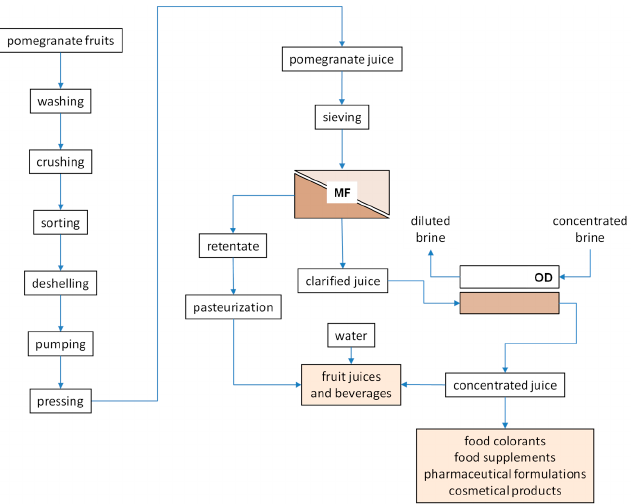
Figure 4. Integrated membrane process for the production of high-quality concentrated pomegranate juice (adapted from [56]).